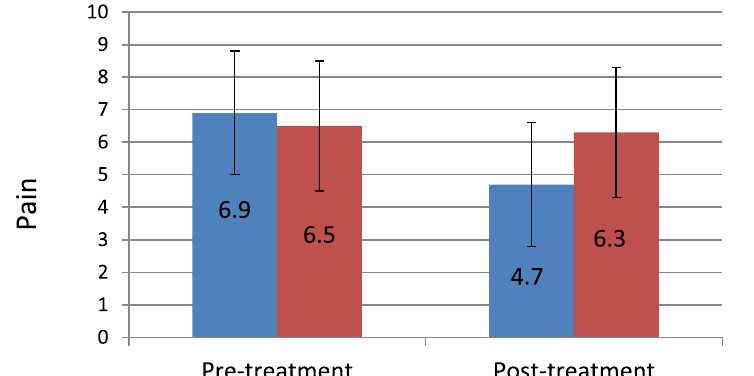
Fig. 6 Mean values of pain pre- and post-treatment between both groups